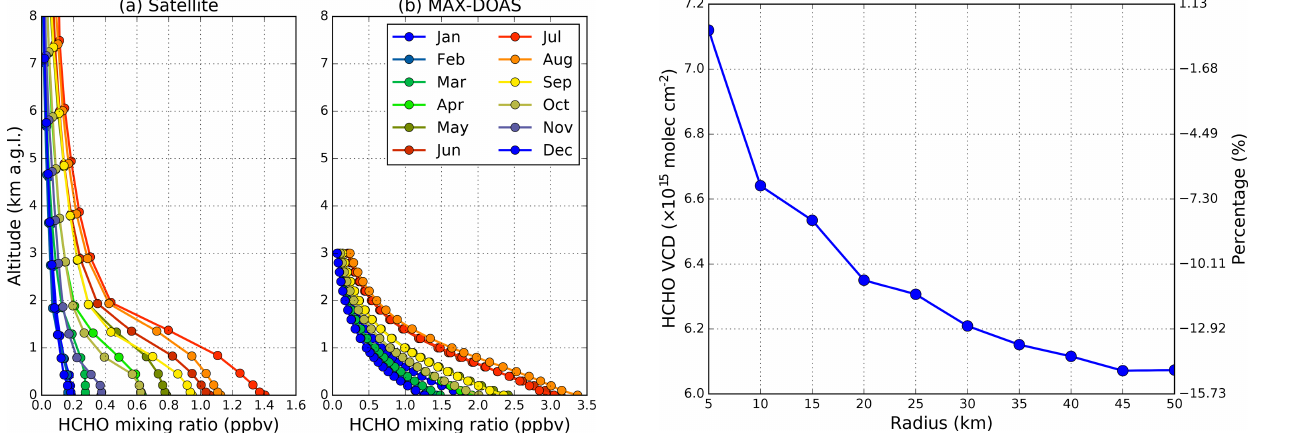
Figure 13. (a) Monthly averages of HCHO mixing ratio based on TM5 simulations as used a priori profiles in the satellite retrieval. (b) MAX-DOAS measurements of HCHO profiles.